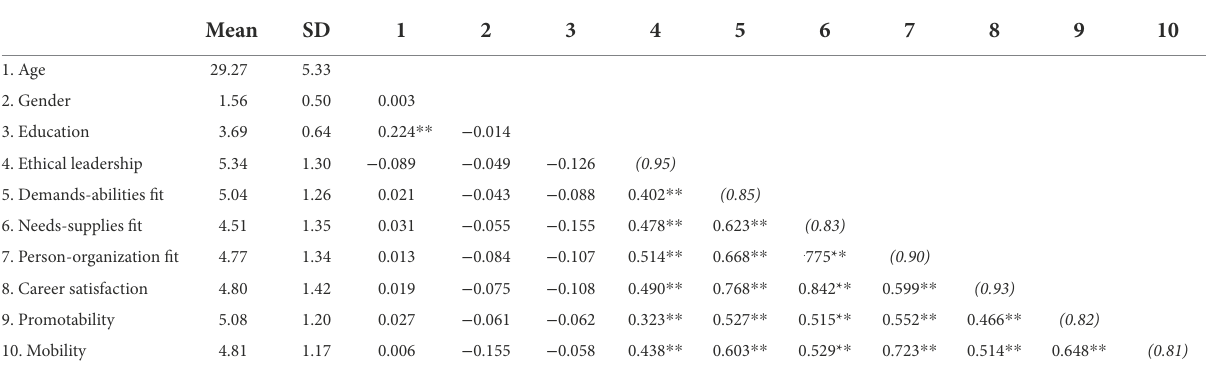
TABLE 2 Descriptive statistics among research